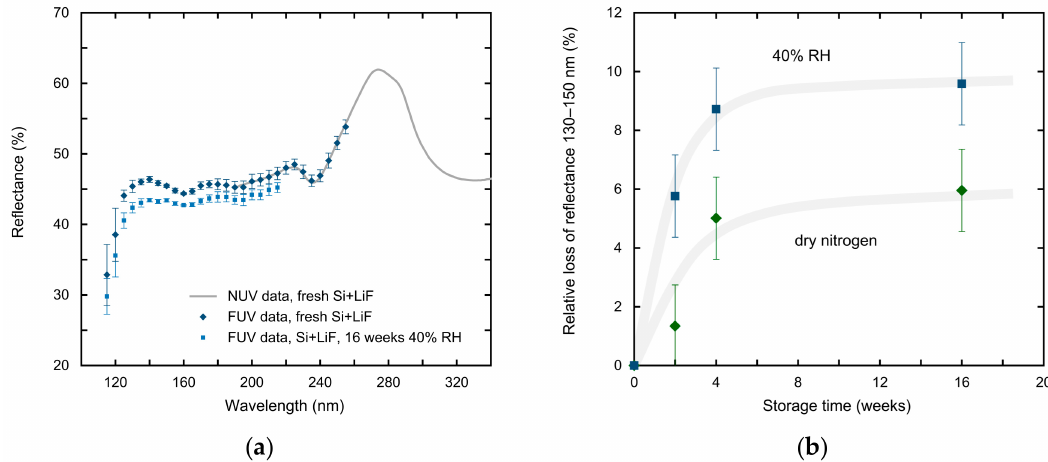
Figure 5. ( a ) The measured FUV and NUV reflectance of 30 nm of LiF deposited on silicon measured immediately following deposition and after 16 weeks of storage at 40% RH at room temperature; ( b ) The relative change in reflectance average over 130–150 nm for samples in 40% RH versus samples stored in dry